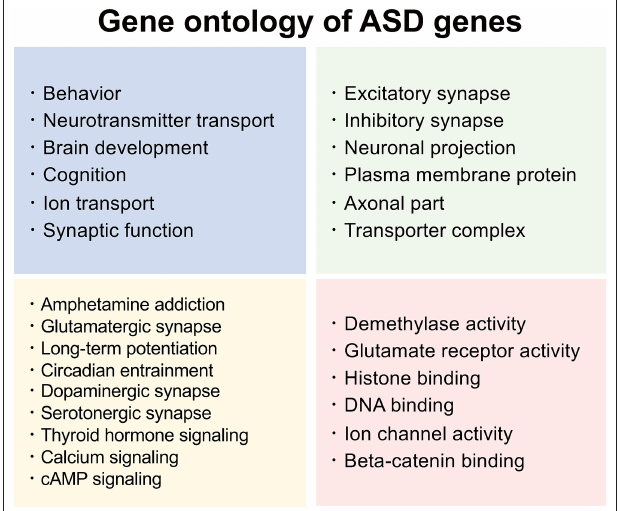
FIGURE 1 | Summarized functions of ASD genes. Functional and related pathway information based on gene ontology of the latest SFARI ASD genes (1,031 genes released on January 11, 2022). SFARI Gene: https://www.sfari.